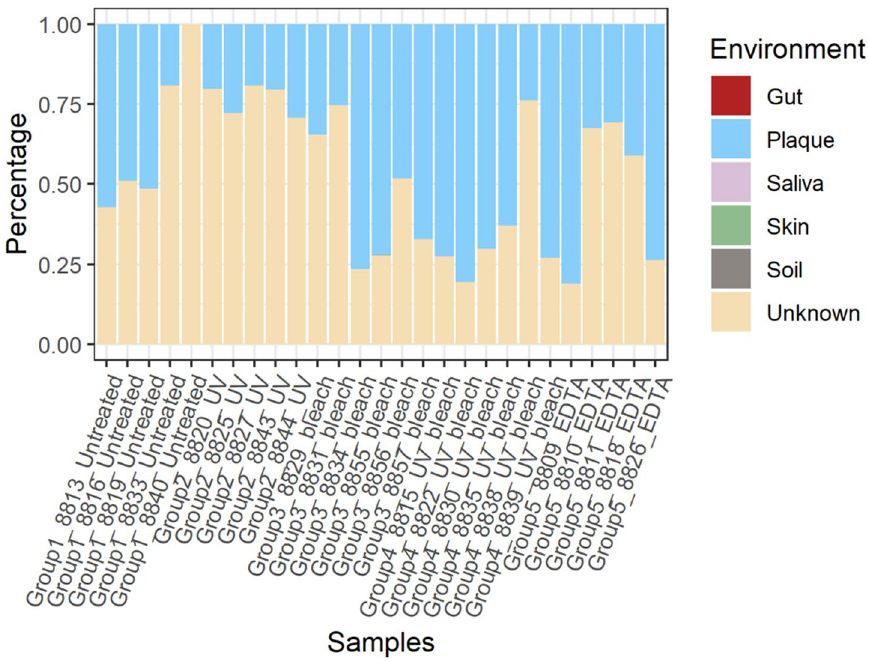
Figure 5. Stacked bar plots of Bayesian SourceTracker results for the shotgun dataset. The estimated proportions of source contribution at the species level, using gut, plaque, saliva, skin, and soil sources. Reads which could not be assigned to an environment were classified as ‘Unknown’ in SourceTracker. Plot was generated with ggplot2 60